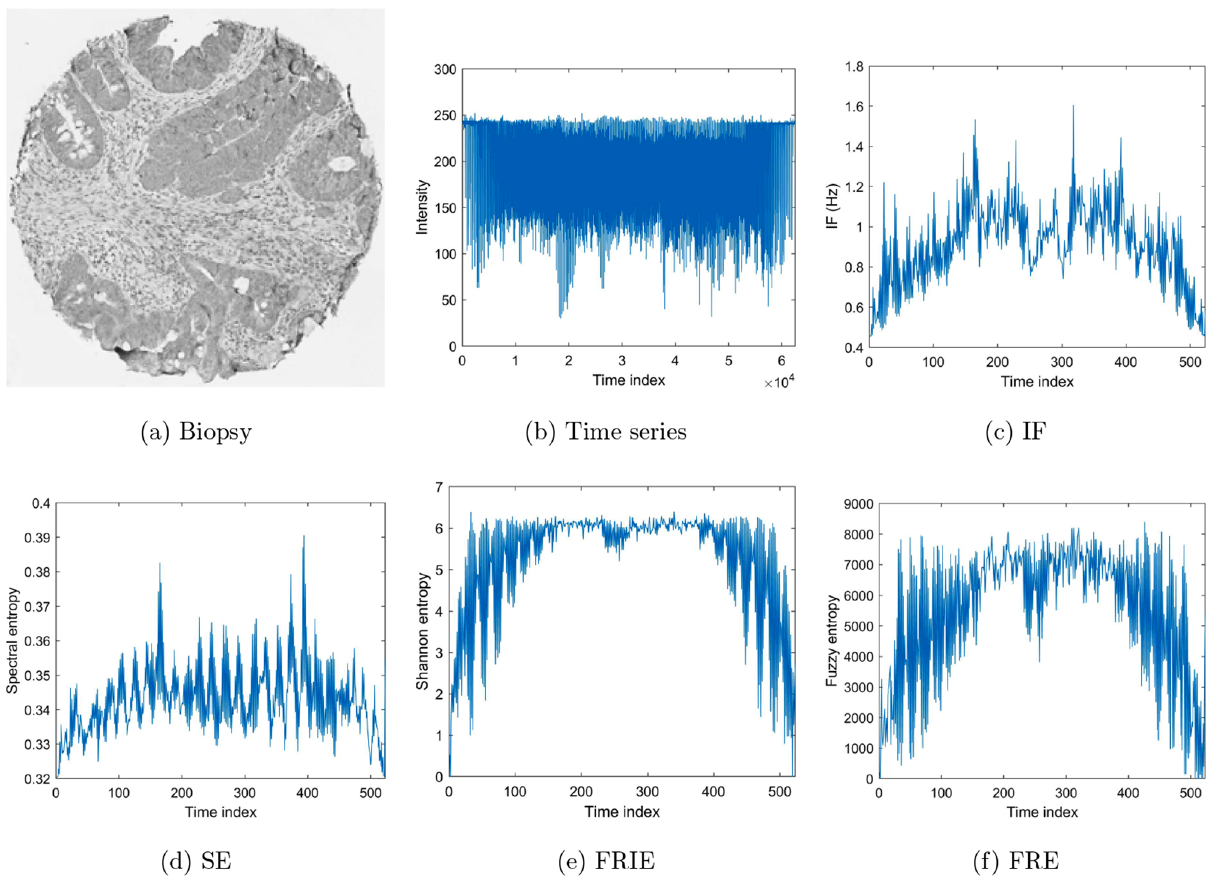
Figure 7. Time-frequency and time-space features extracted from time series of a grayscale image of IHC rectal-cancer tissue obtained from a patient having survival rate ≤ 5 years.